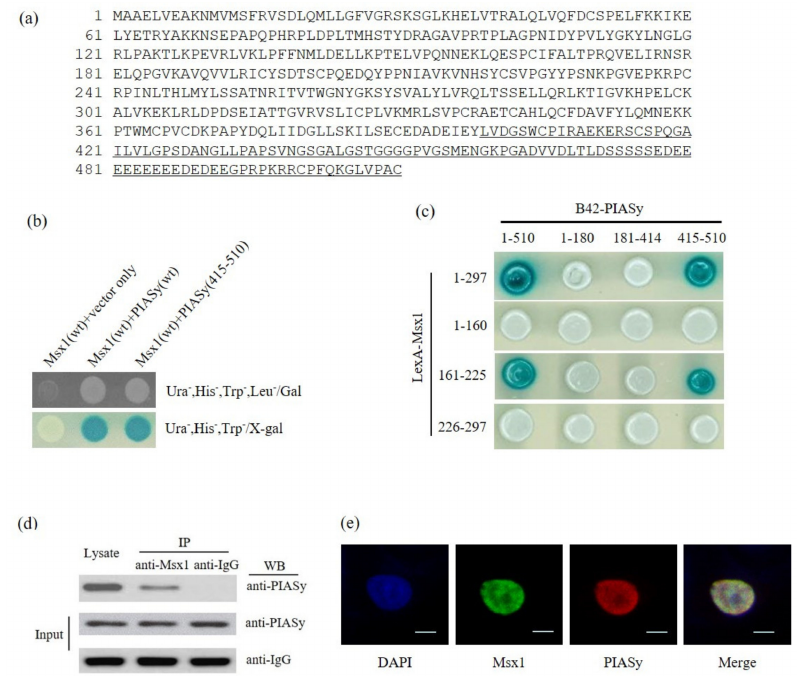
Figure 3. Homeoprotein Msx1 interacts with PIASy. ( a ) Identification of PIASy as Msx1-interacting protein by yeast 2-hybrid (Y2H) screening. The amino acid sequence of PIASy is presented using single letter abbreviations. The underlined amino acid sequence is the translated PIASy protein isolated from the yeast two-hybrid (Y2H) assay. Msx1 and PIASy cDNA constructs were introduced into EGY48 yeast host strains to test for protein-protein interactions within the Y2H analysis system. Transformants were examined for their ability to grow on a medium lacking leucine at 30 ◦ C ( b , upper panel) and for β -galactosidase expression (b, bottom panel). ( c ) Biological interaction between cDNA constructs for three truncated Msx1 (Met 1 -Leu 160 , Arg 161 -Gln 225 , and Glu 226 -Thr 297 ) and three deleted PIASy (Met 1 -Arg 180 , Glu 181 -Ser 414 , and Cys 415 -Cys 510 ) fusion proteins in the Y2H analysis system. ( d ) Interaction of Msx1 and PIASy in mammalian cells. HEK 293 cells were infected with Ad-mock or Ad-Msx1 and then transiently transfected with Flag-PIASy harboring a full-length PIASy. The whole cell lysates were used for immunoprecipitation with anti-IgG or anti-Msx1 antibody, followed by immunoblotting with anti-Flag antibody. Expression of Msx1 was confirmed by immunoblotting with anti-Msx1 antibody. ( e ) Nuclear co-localization of Msx1 and PIASy in human ovarian cancer cells. Human ovarian cancer 2774 cells were co-transfected with pEGFP-Msx1 expressing a full-length Msx1 and Flag-PIASy expressing a full-length PIASy and then subjected to indirect immunofluorescence staining with Alexa Fluor 568-conjugated secondary antibody. The subcellular co-localization of Msx1-PIASy was examined using confocal microscopy. The co-localization of EGFP-Msx1 and Flag-PIASy is shown in the merged images. Scale bar, 10 µ